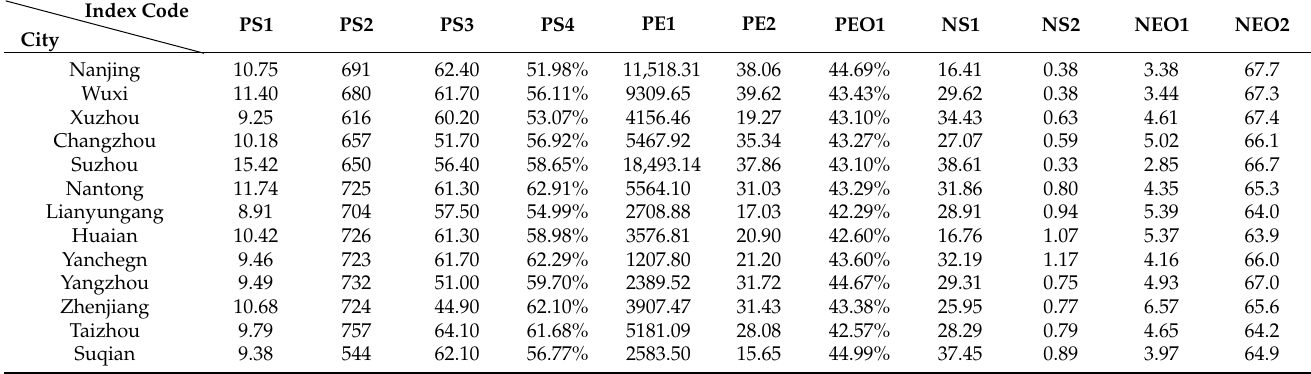
Table 3. Data of the externality indexes of highway infrastructures in cities of Jiangsu in